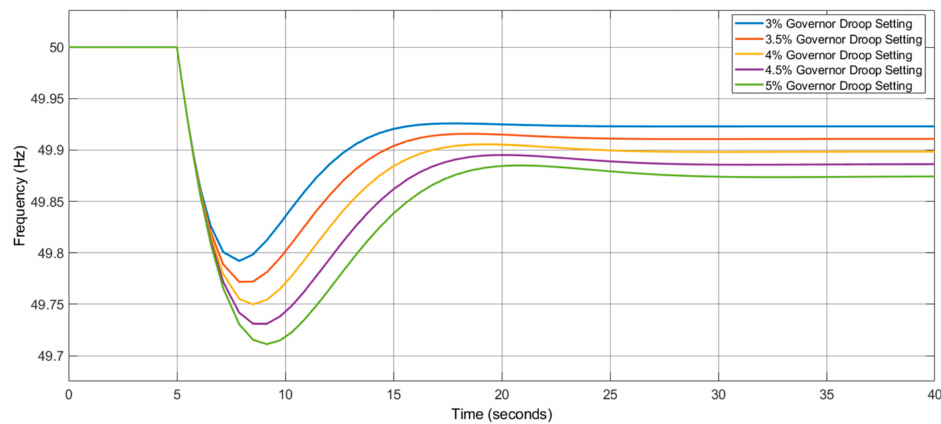
Figure 10. Impact of the governor droop setting on the primary frequency response.